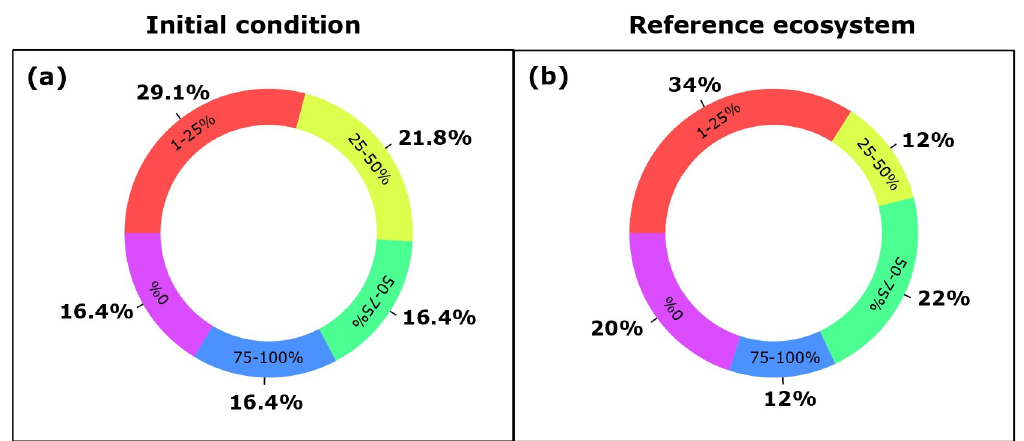
Fig 2. Recovery of biodiversity. Percentage of projects in each of four class types (inside the donuts) indicating degree of biodiversity recovery compared with (a) the initial condition of the ecosystem and (b) a reference ecosystem. The total number of projects analyzed was 55 in (a) and 50 in (b).